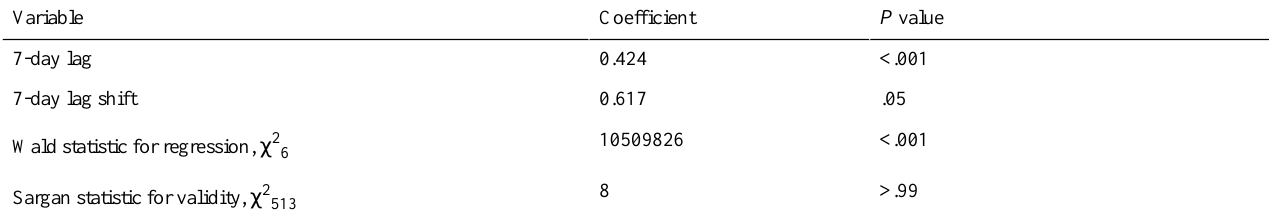
Table 1. Arellano–Bond dynamic panel data model of COVID-19 dynamics at the country level.